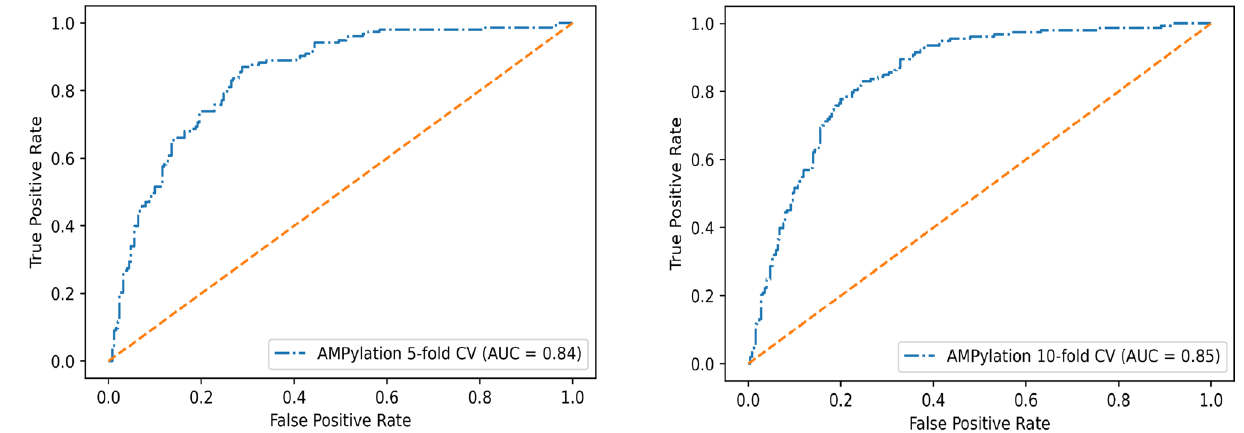
Figure 1. Receiver operating characteristic (ROC) curves for 5-fold CV and 10-fold CV DeepAmp